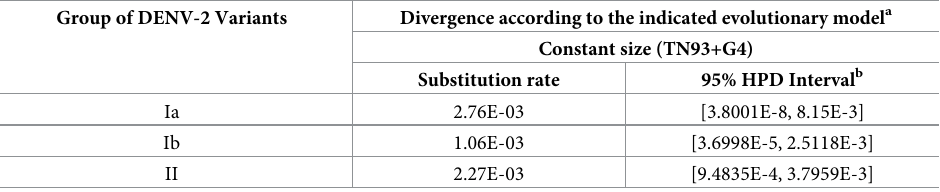
Table 2. Evolutionary characteristics of the E gene of the three DENV-2 variants.